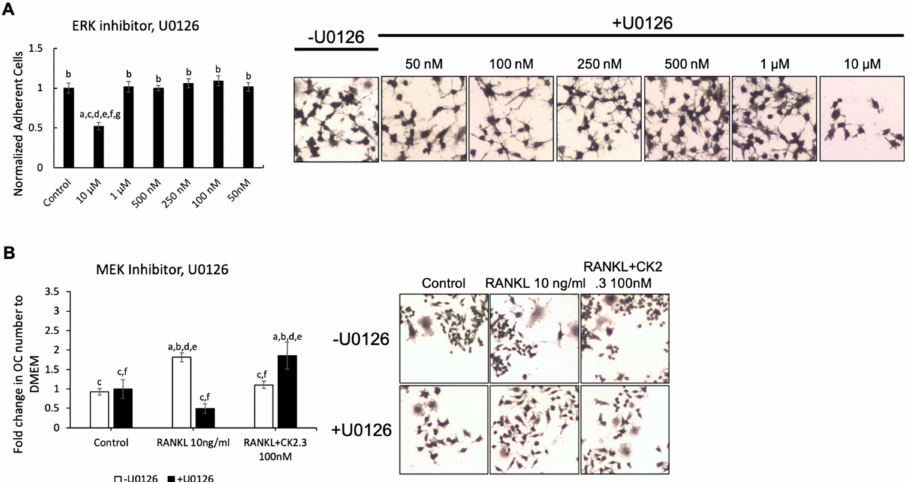
Figure 3. MEK inhibitor, U0126, abolished the antagonistic e ff ect of CK2.3 on RANKL-induced osteoclastogenesis. ( A ) Concentration curve for U0126 to determine the working concentration. a: denotes significant di ff erence from Control, b: denotes significant di ff erence from 10 µ M, c: denotes significant di ff erence from 1 µ M, d: denotes significant di ff erence from 500 nM, e: denotes significant di ff erence from 250 nM, f: denotes significant di ff erence from 100 nM, and g: denotes significant di ff erence from 50 nM. ( B ) The e ff ect of U0126 on the antagonistic e ff ect of CK2.3 on RANKL-induced osteoclastogenesis. a: denotes significant di ff erence from Control without inhibitor, b: denotes significant di ff erence from Control with inhibitor, c: denotes significant di ff erence from RANKL at 10 ng / mL without inhibitor, d: denotes significant di ff erence from RANKL at 10 ng / mL with inhibitor, e: denotes significant di ff erence from RANKL + CK2.3 at 100 nM without inhibitor, and f: denotes significant di ff erence from RANKL + CK2.3 at 100 nM with